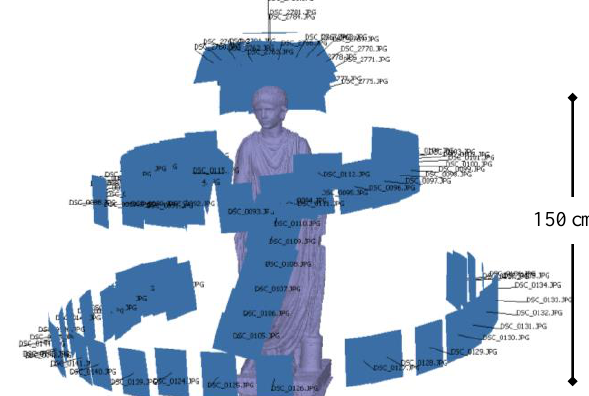
Figure 6. Typical camera network characterizing the sculptures photogrammetric